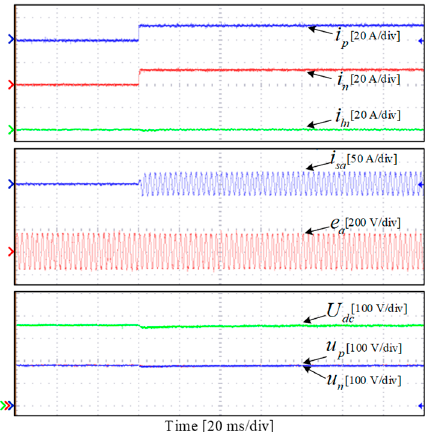
Figure 15. Load step experimental results under a balanced load condition.